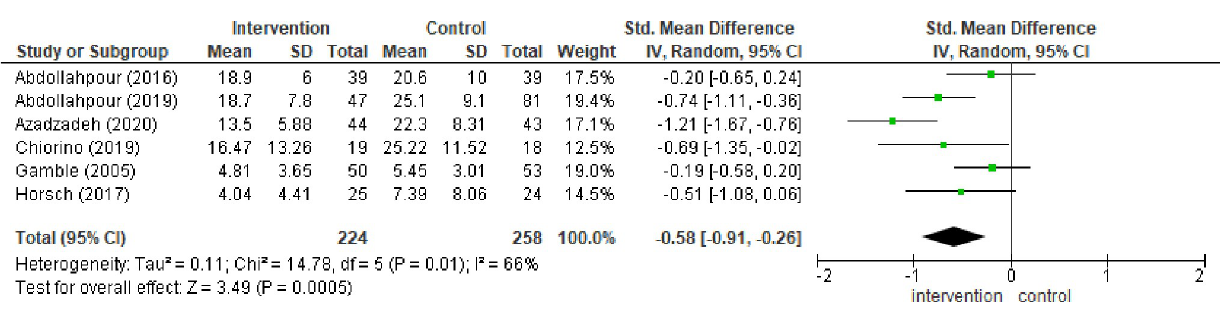
Fig 4. Forest plot: Symptom severity 4–6 weeks post-partum.